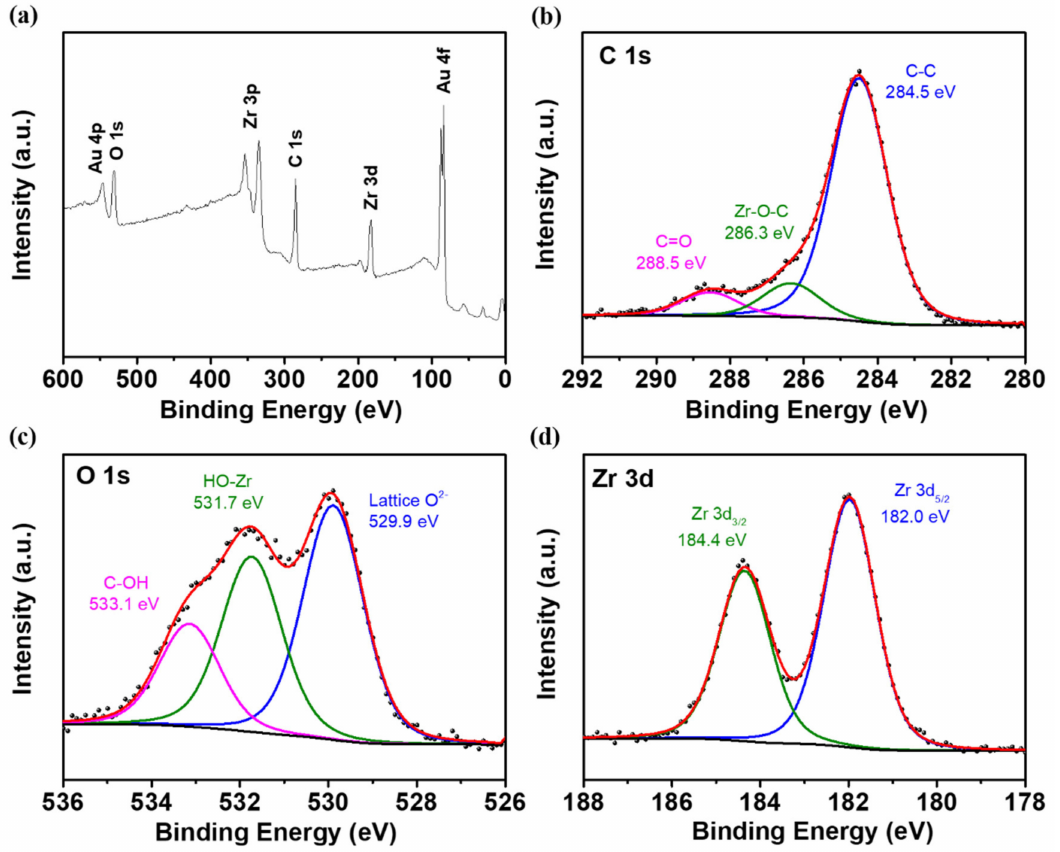
Figure 5. XPS spectra showing ( a ) the wide scan and the narrow scans of ( b ) C 1s, ( c ) O 1s, and ( d ) Zr 3d for